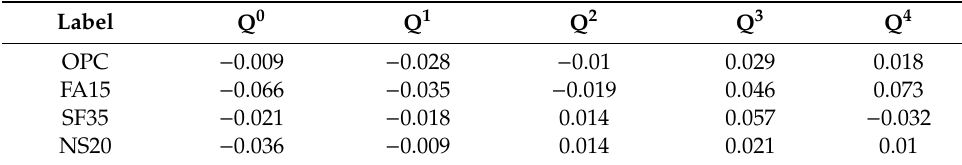
Table 5. Di ff erence in Q n after